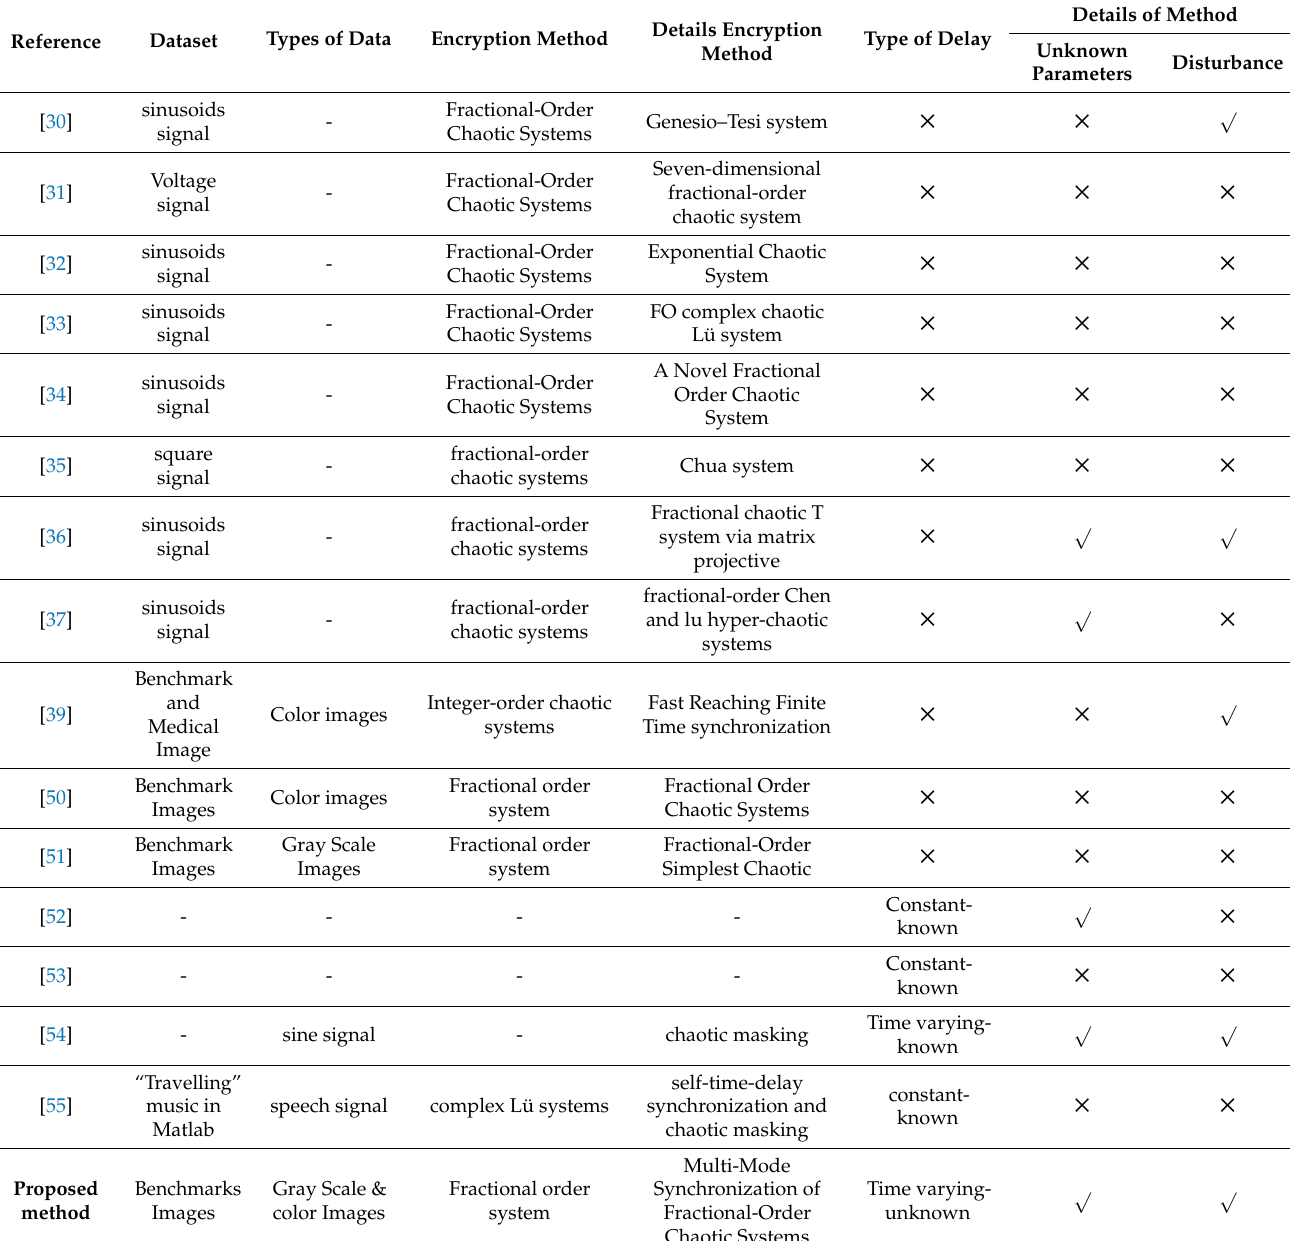
Table 2. Comparison of the proposed method with other related